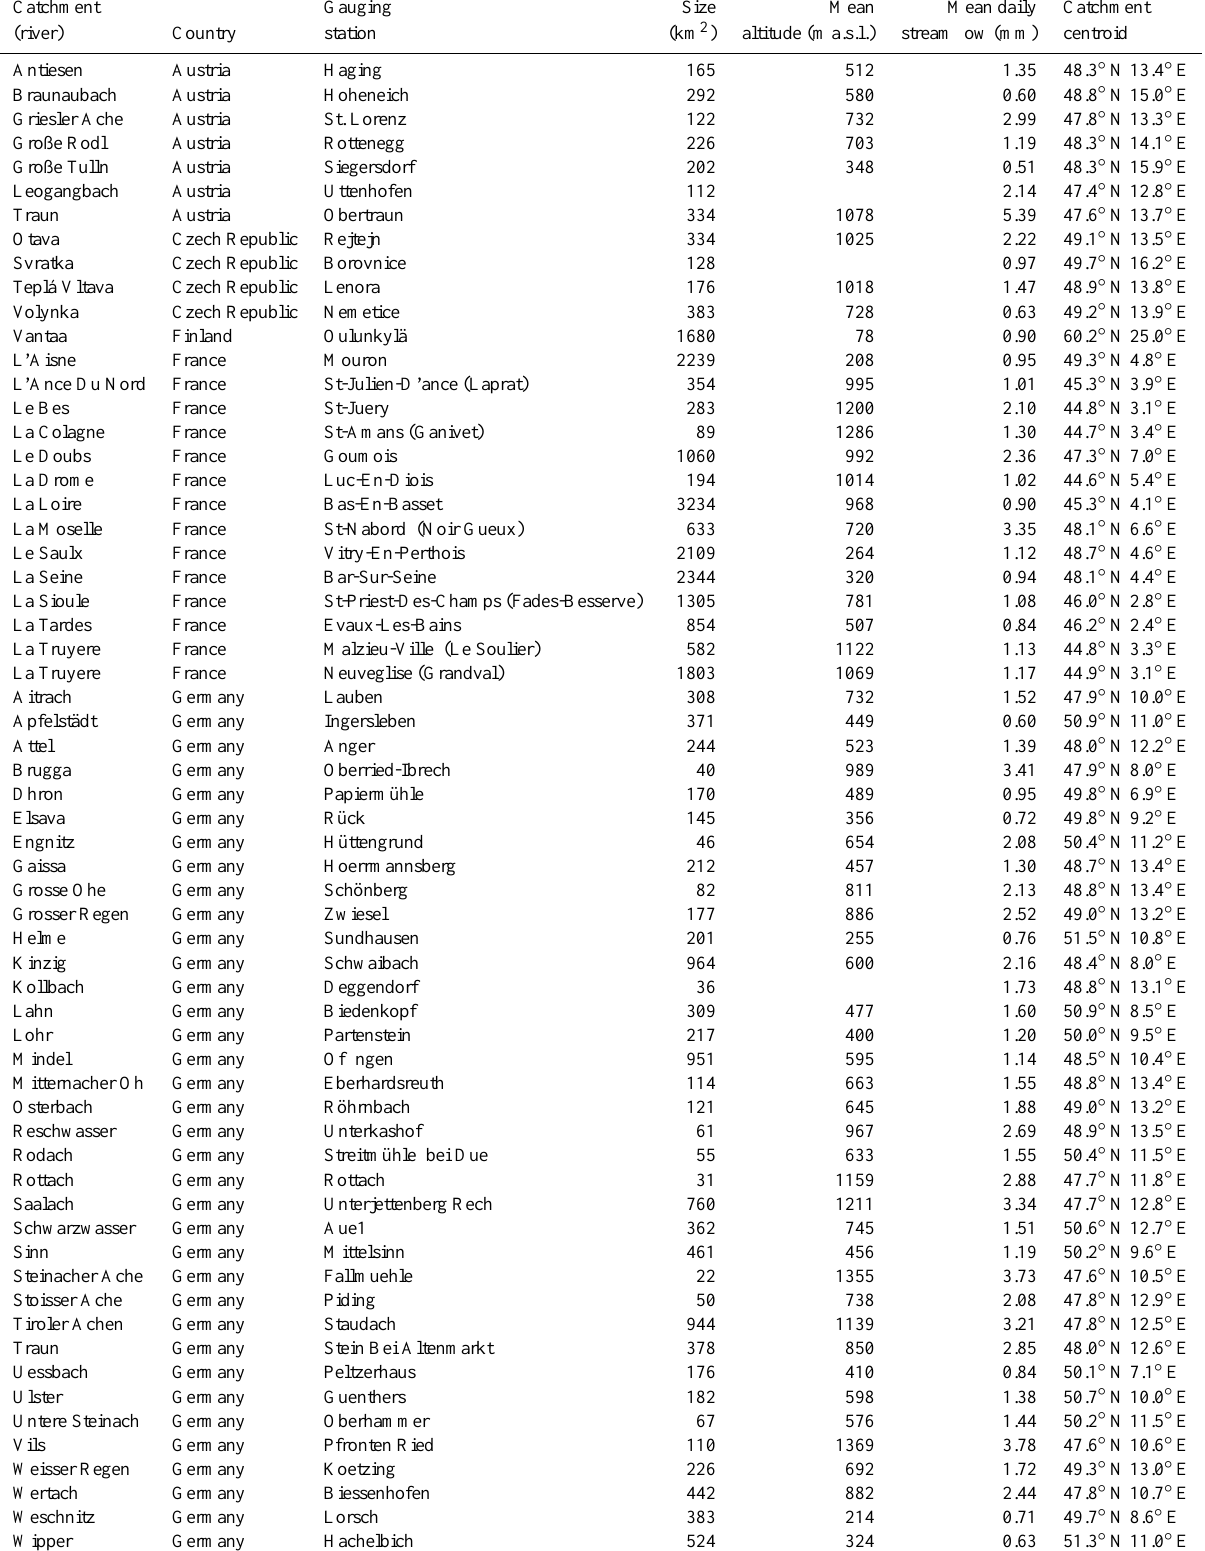
Table A1. Overview of catchments. Catchment Gauging Size Mean Mean daily Catchment (river) Country station altitude